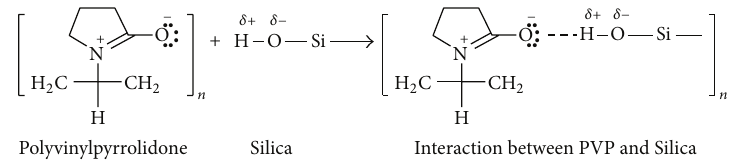
Scheme 2: Schematic presentation of the adsorption of PVP on silica.